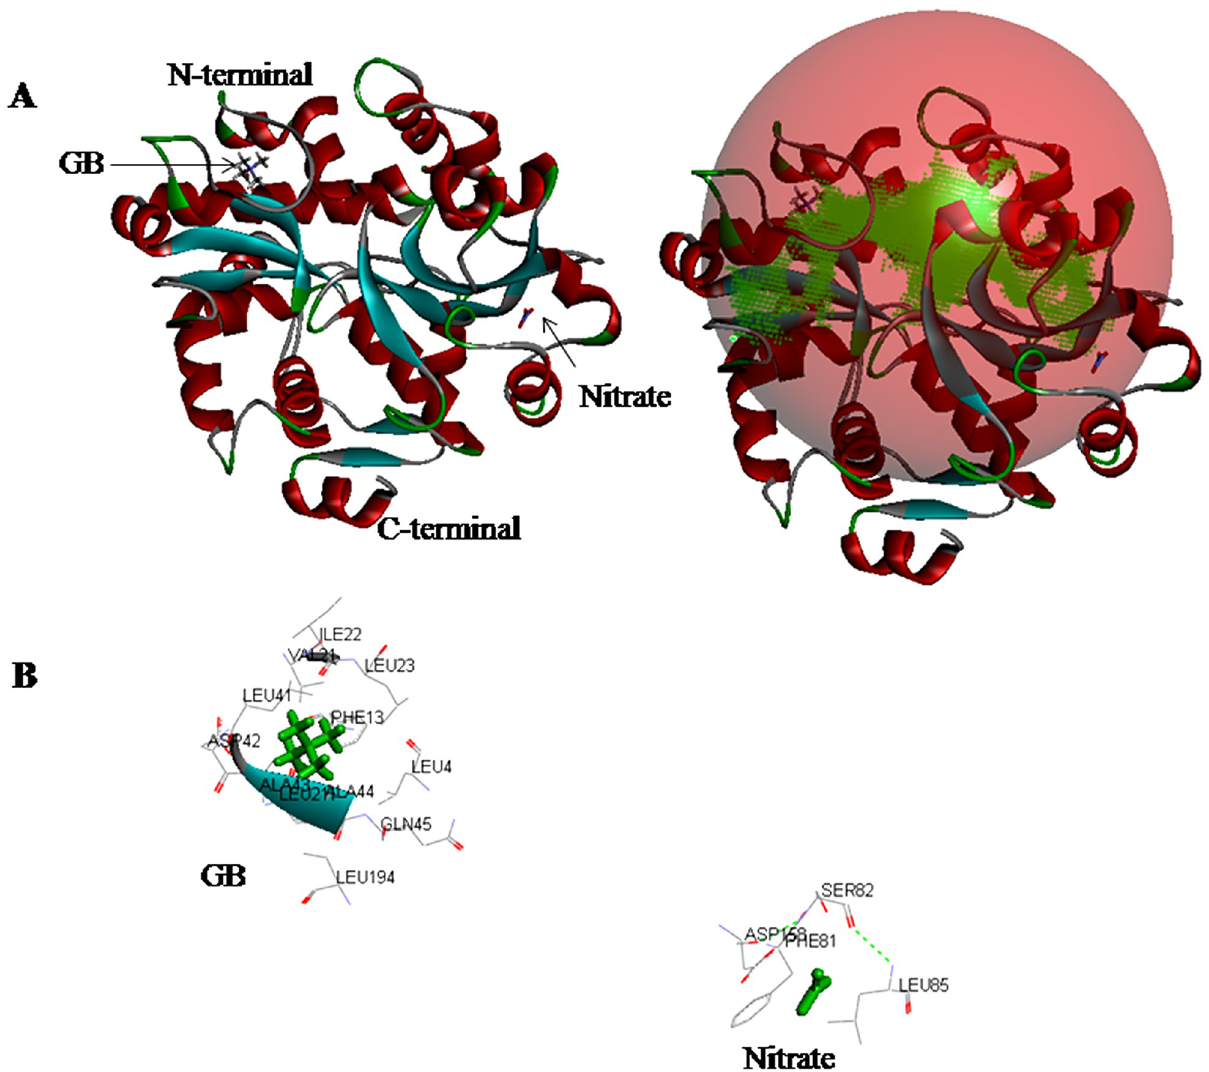
Fig 14. Docking of ligands GB and nitrate with target protein nrtC. (A) Poses of docked complexes; green color in the sphere indicates prominent active site on which the ligand interacted. (B) 3D level interaction.